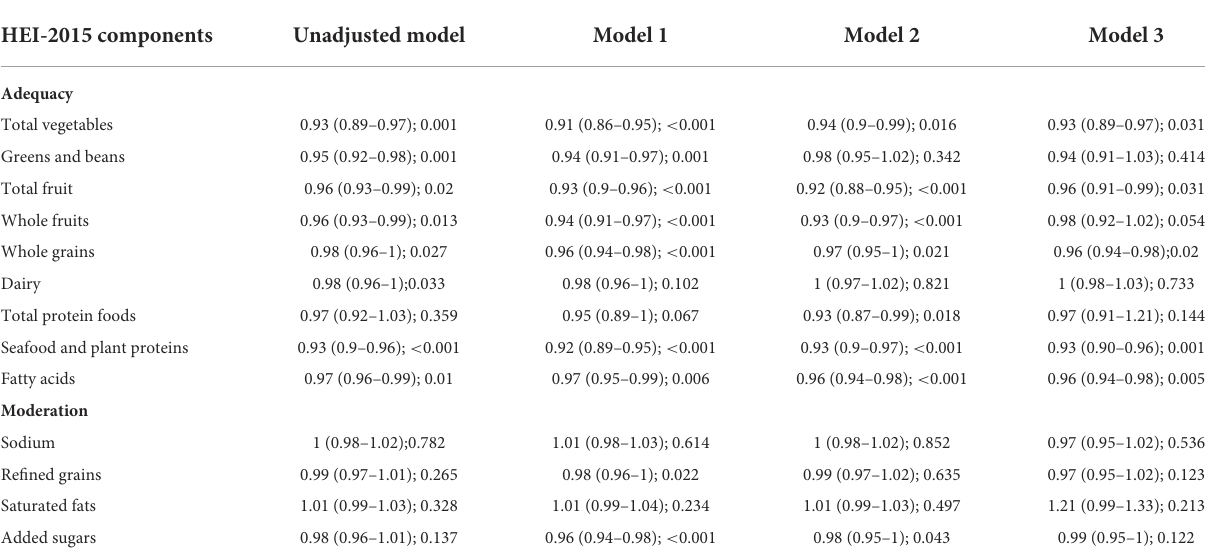
seafood and plant proteins, whole grains; total fruit and total vegetables were all significantly associated with periodontitis (Table 3). Table 4 shows the actual effect of smoking, age and gender, with the results suggesting that the absence of a smoking history has a protective effect against periodontitis.